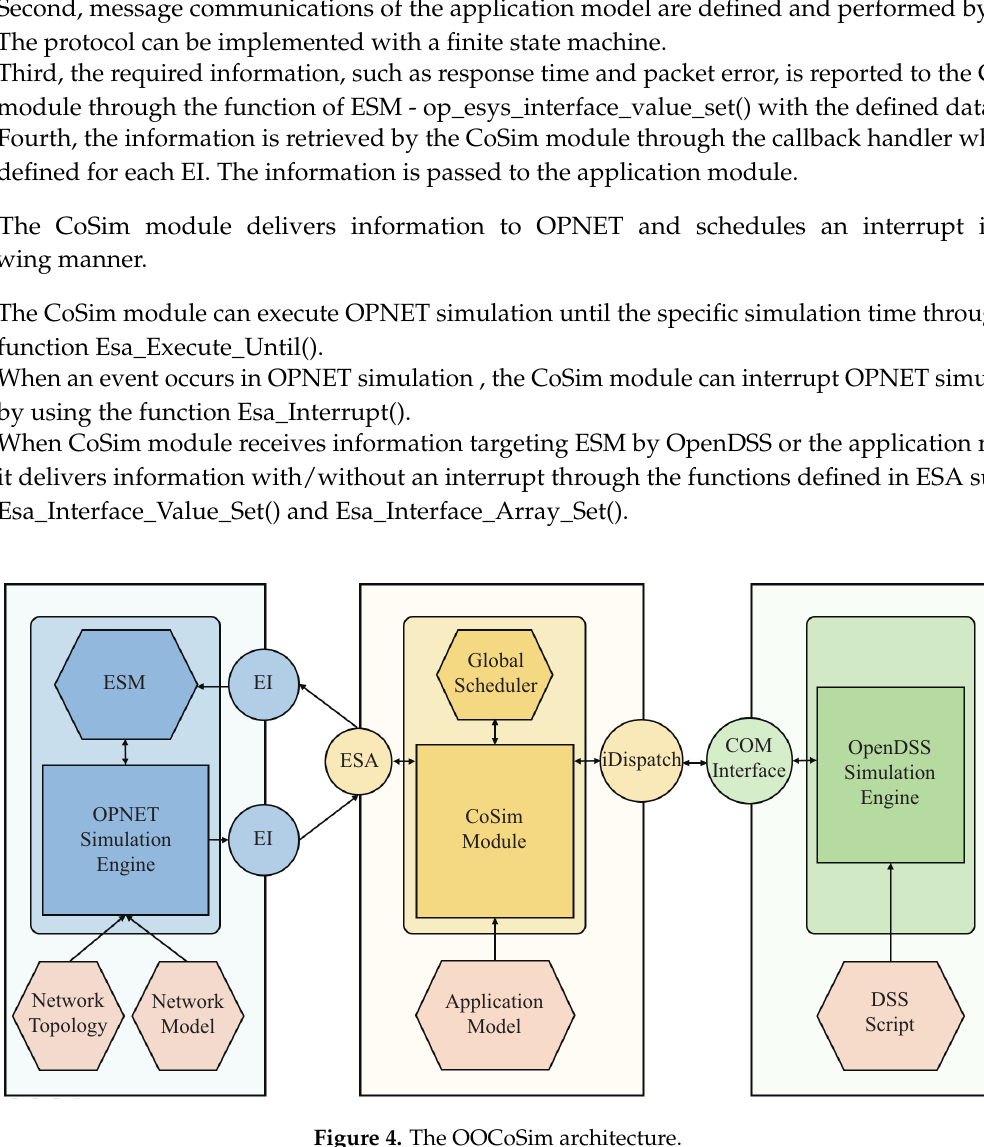
Figure 4. The OOCoSim